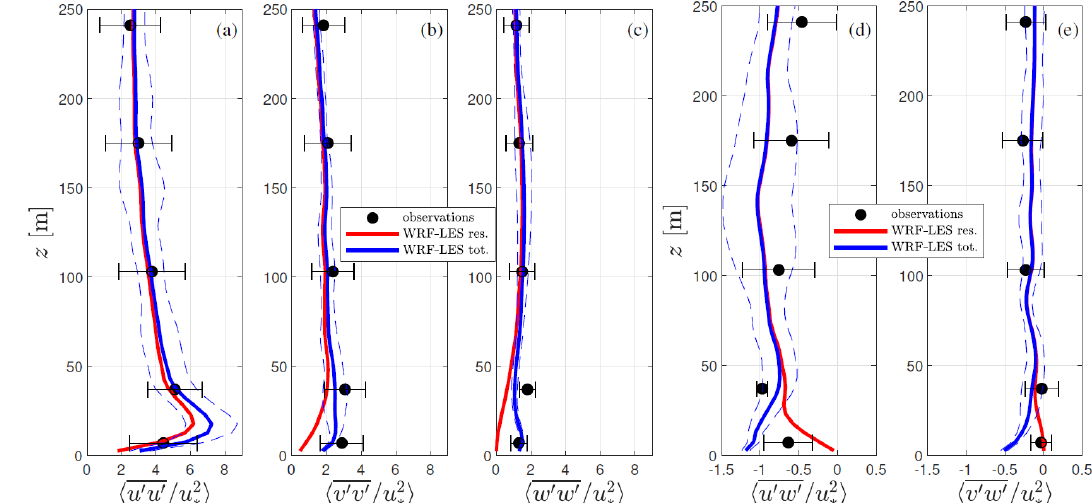
Figure 9. Simulated and observed vertical profiles of normalized velocity variances (a, b, c) and covariances (d, e) under neutral conditions. Resolved and total fluxes are shown for the simulations. The error bars and dashed lines denote ± 1 standard deviation from the mean of the observations and simulations,